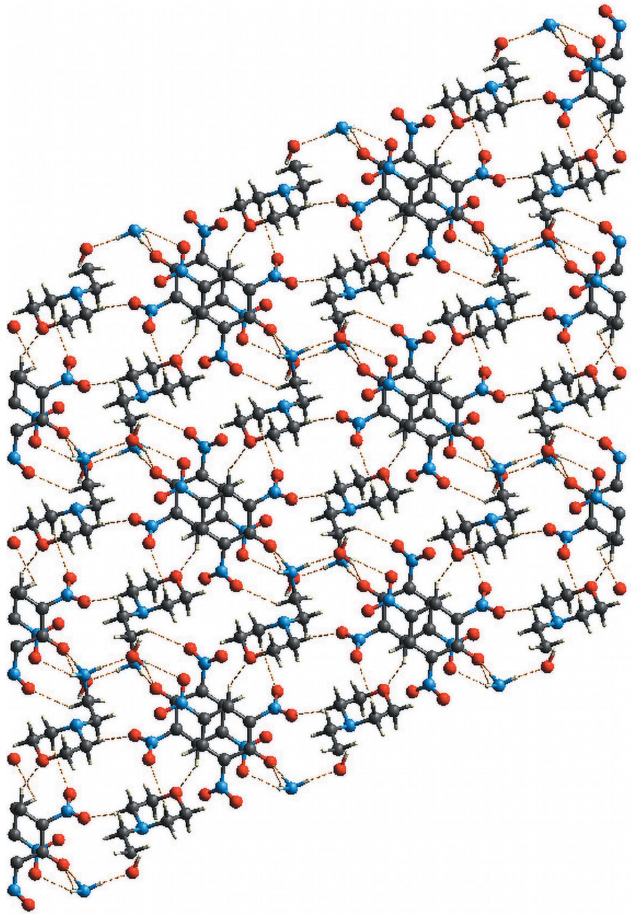
Figure 3 Three-dimensional supramolecular architecture of the title compound viewed down the a axis.